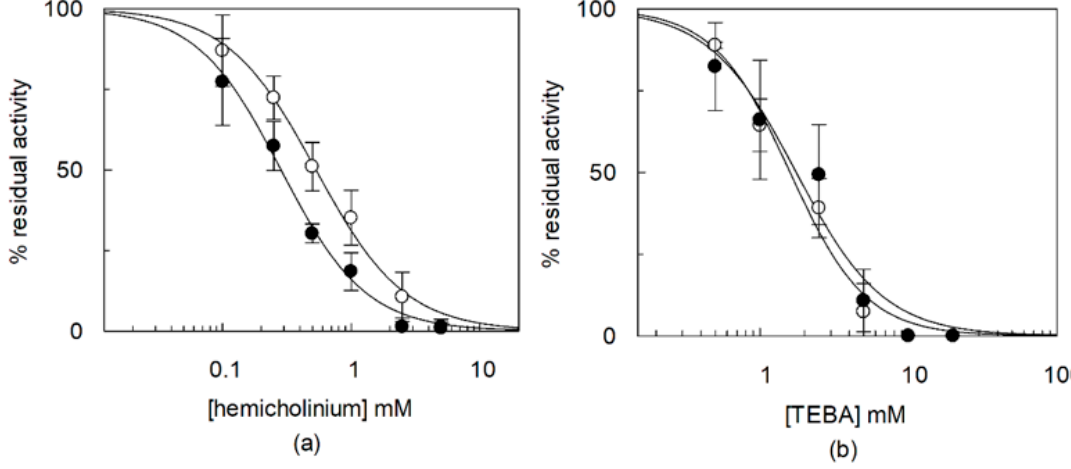
Figure 7. E ff ect of hemicholinium and TEBA on the OCTN1 activity measured in the presence or absence of CHS. The recombinant OCTN1 was reconstituted in liposomes as described in Section 4.5. except that in the absence ( ○ ) or in the presence ( ● ) of 8.3% CHS corresponding to 83 µg CHS/mg total lipids. ( a ) Transport was started adding 0.1 mM [ 3 H]-acetylcholine at time zero to proteoliposomes in the presence of increasing external hemicholinium concentrations (0-0.1-0.3-0.5-0.8-1-1.5-2.6 mM) or ( b ) adding 0.1 mM [ 14 C]-TEA in the presence of increasing external TEBA concentrations (0-0.5-1-2.5-5-10-20 mM). The transport reaction was stopped at 20 min. Percent residual activity with respect to the control data were interpolated in an IC 50 equation (Dose-response curves). The values are means ± SD from three experiments.